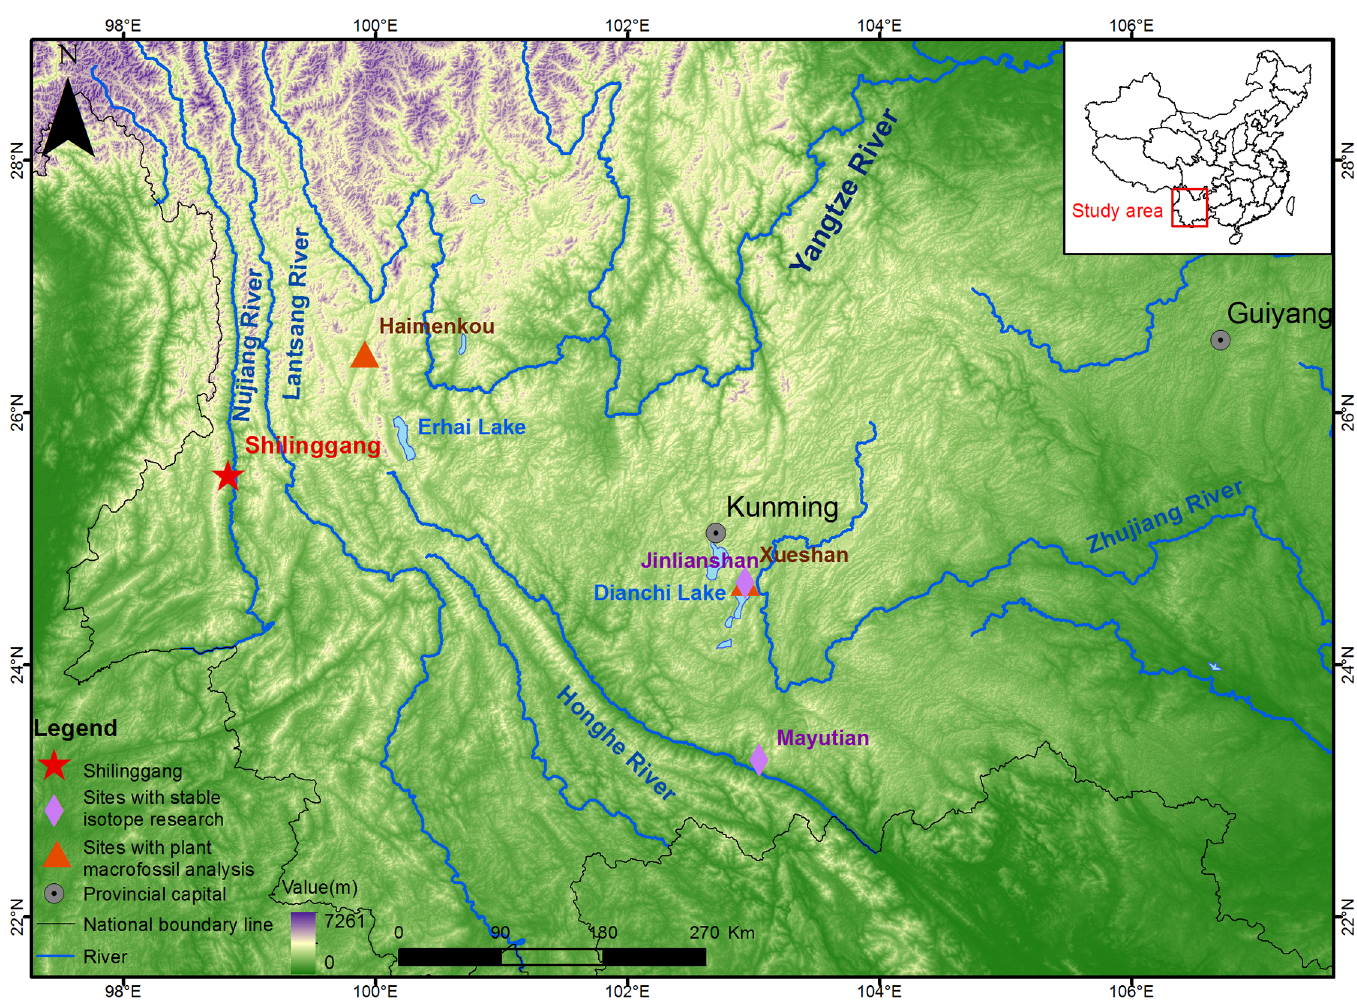
Fig 1. The location of Shilinggang and other sites mentioned in the text. DEM (digitalelevationmodel) data was downloaded from Geospatial Data Cloud(http://www.gscloud.cn/),and map features in the figure were modified from Li et al. [28].